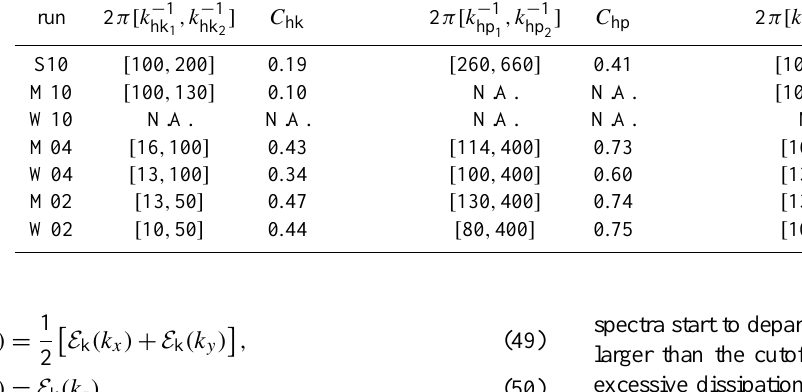
Table 2. Definitions of the inertial ranges expressed in wavelengths, λ h = 2 π/k h ( m), and scaling factors for kinetic energy spectra ] ; potential energy spectra [ k [ k hk 1 ,k hk 2 displays the average potential-to-kinetic energy ratio R kp in the range [ k hp